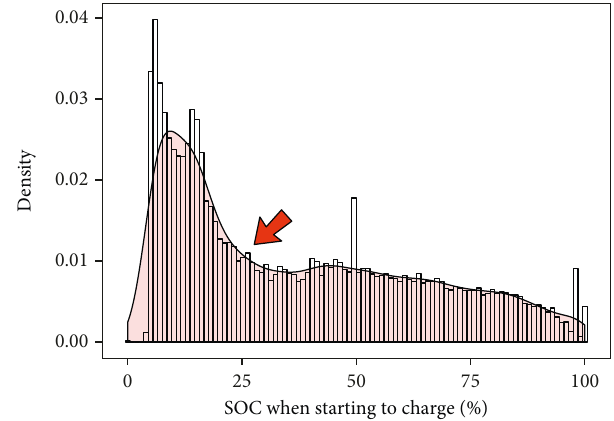
Figure 3: Histogram of SOC when starting to charge.